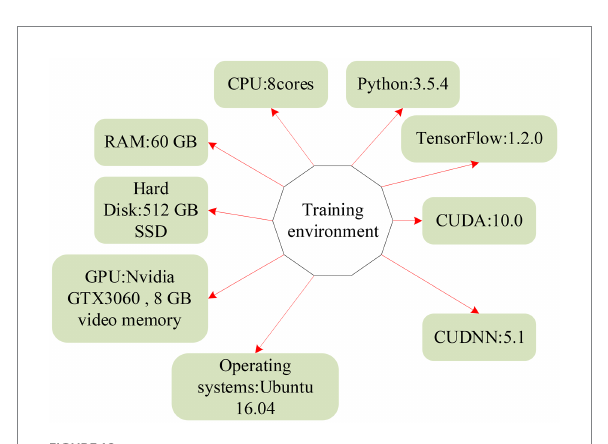
FIGURE 12 Framework diagram of the training environment.